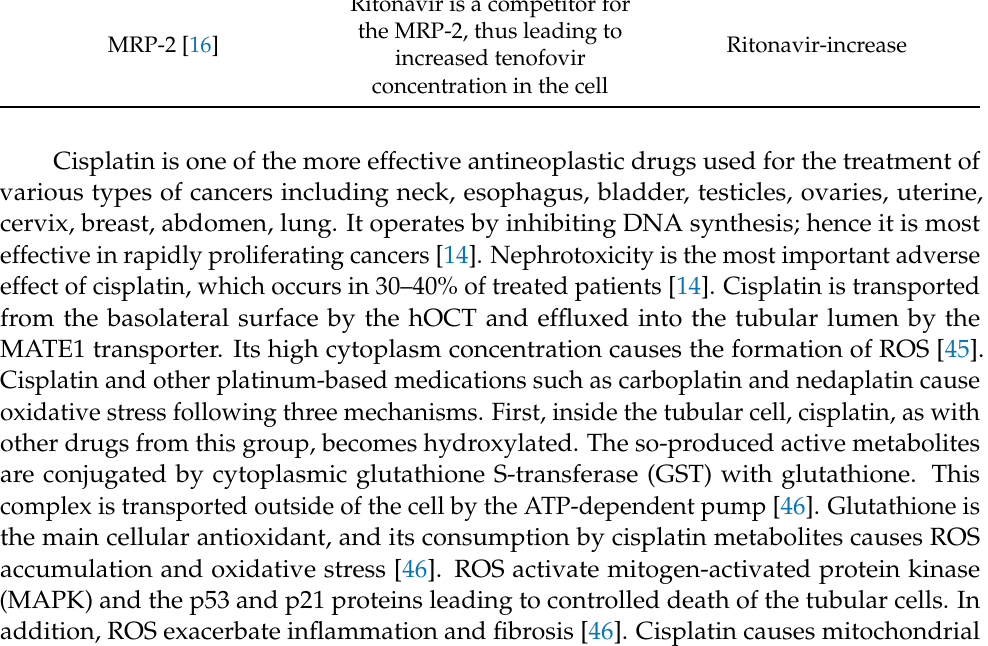
Table 2. The effects of individual drugs on the activity of basolateral membrane transporters causing the influx of tenofovir and other medications from this group into the cell, and of the apical membrane transporters causing their efflux from the cell. The effect of drugs on blood tenofovir levels. Tenofovir’s Transporters Type and Effect of Drugs Drugs Effect on 1 Blood on Transporter Activity Tenofovir Levels hOAT1 [16] Probenecid-inhibition Aciclovir-increase probenecid-inhibition dipyridamole-inhibition NSAIDs-inhibition cidofovir-inhibition MRP-4 [16,41] aciclovir-inhibition valaciclovir-inhibition ganciclovir-inhibition valganciclovir-inhibition Ritonavir is a competitor for the MRP-2, thus leading to MRP-2 [16] increased tenofovir concentration in the cell